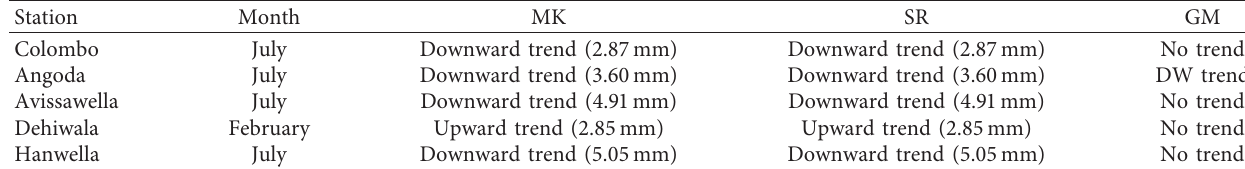
Table 4: Trend analysis results for monthly variation at 5% significance